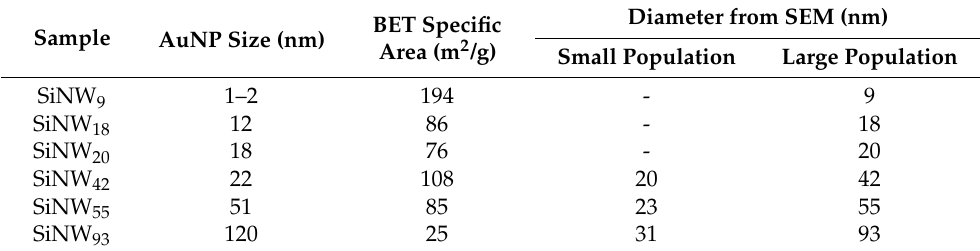
Table 2. Characteristics of the SiNW samples.